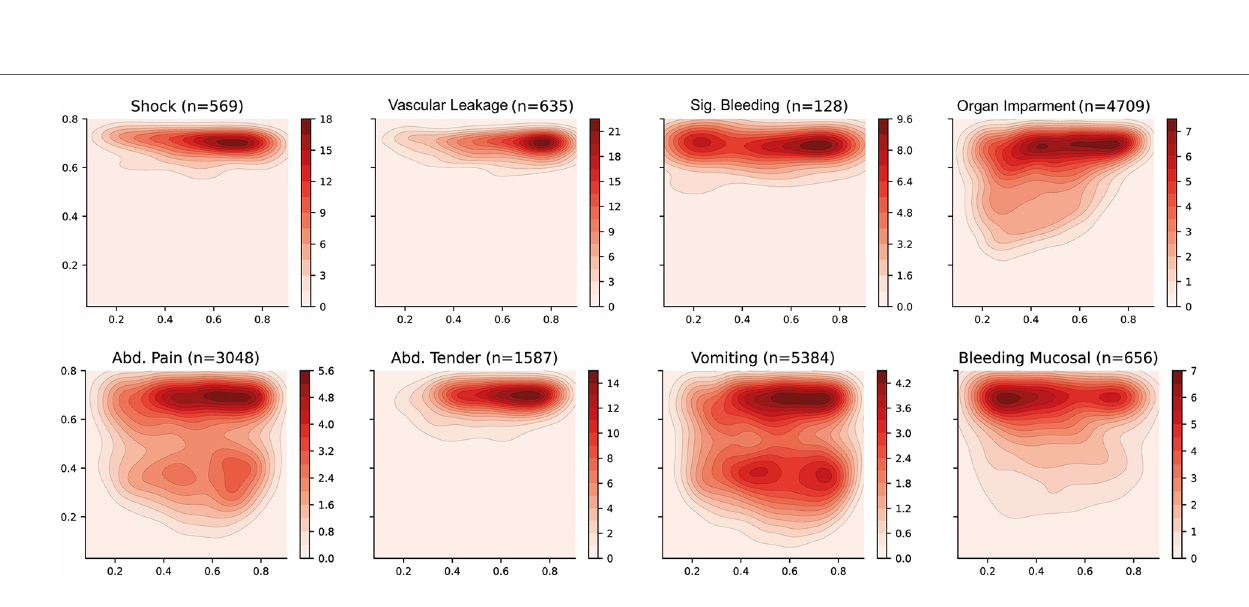
patients in which vascular leakage, signi fi cant bleeding, organ